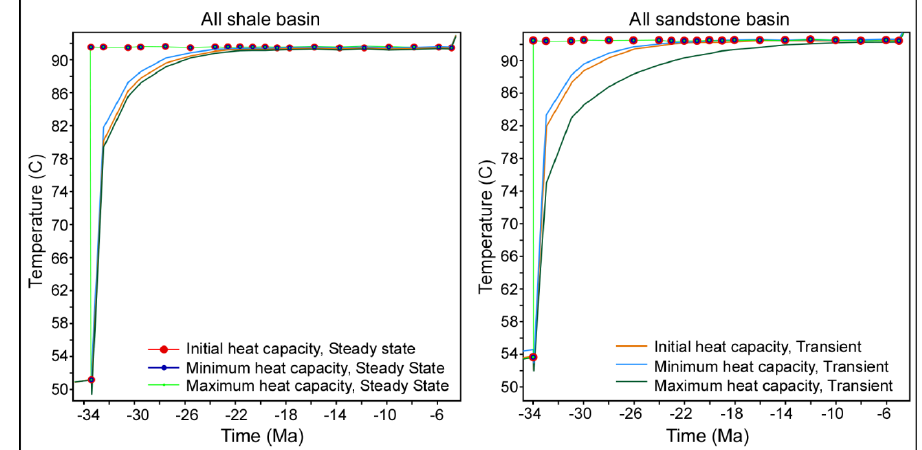
Figure 11. Resulting temperatures for the three tested specific heat capacities for shale and sandstone. Location of studied point indicated in Figure 8b. Heat capacity values given in Table 2.